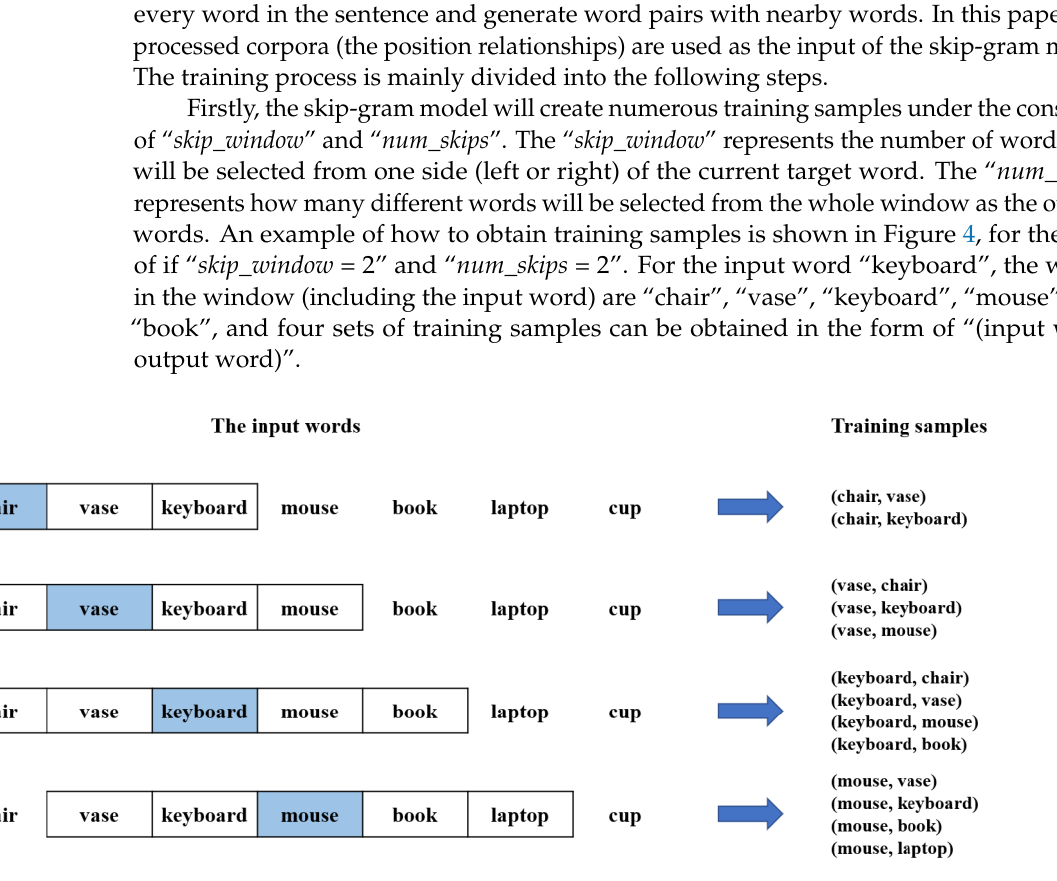
Figure 4. An example of how to obtain the training samples.